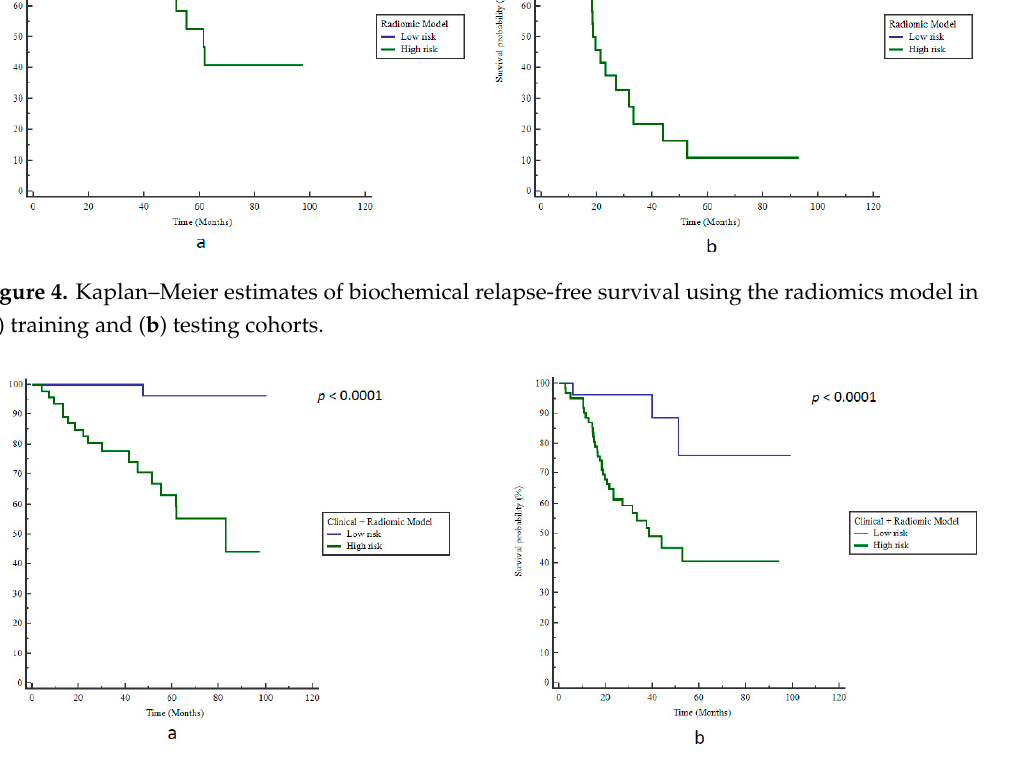
Figure 5. Kaplan–Meier estimates of biochemical relapse-free survival using the radiomics + clinical model in ( a ) training and ( b ) testing cohorts.